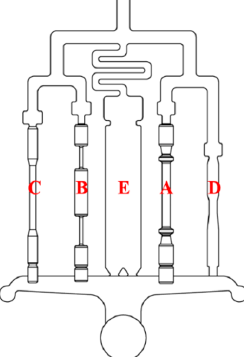
Figure 1. Schematic of die casting specimens.